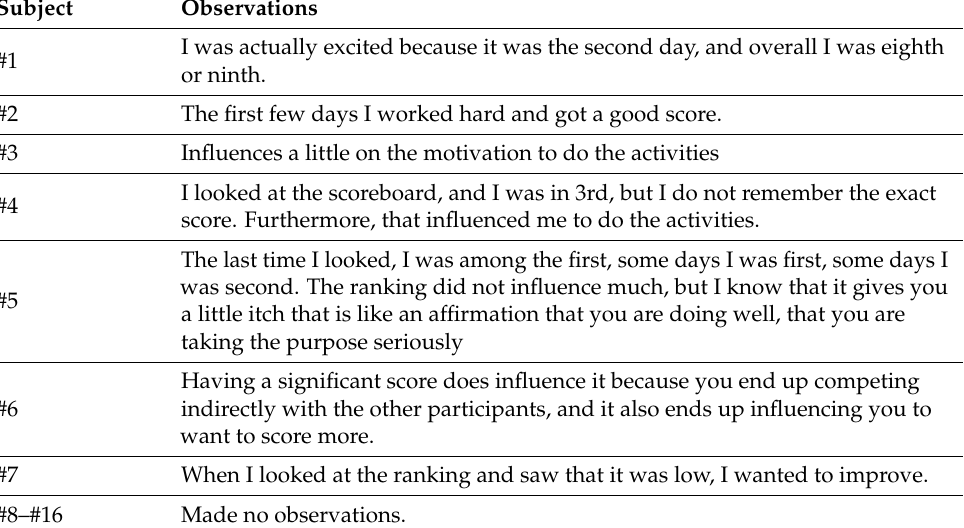
Table 6. Observations about